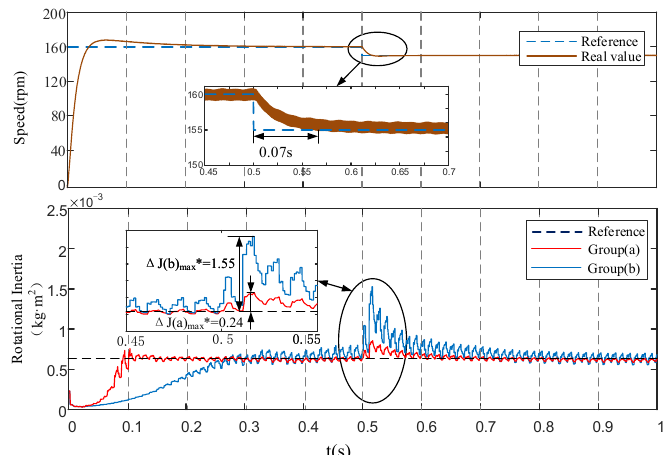
Figure 10. Speed interference identification results of Experiment (i).